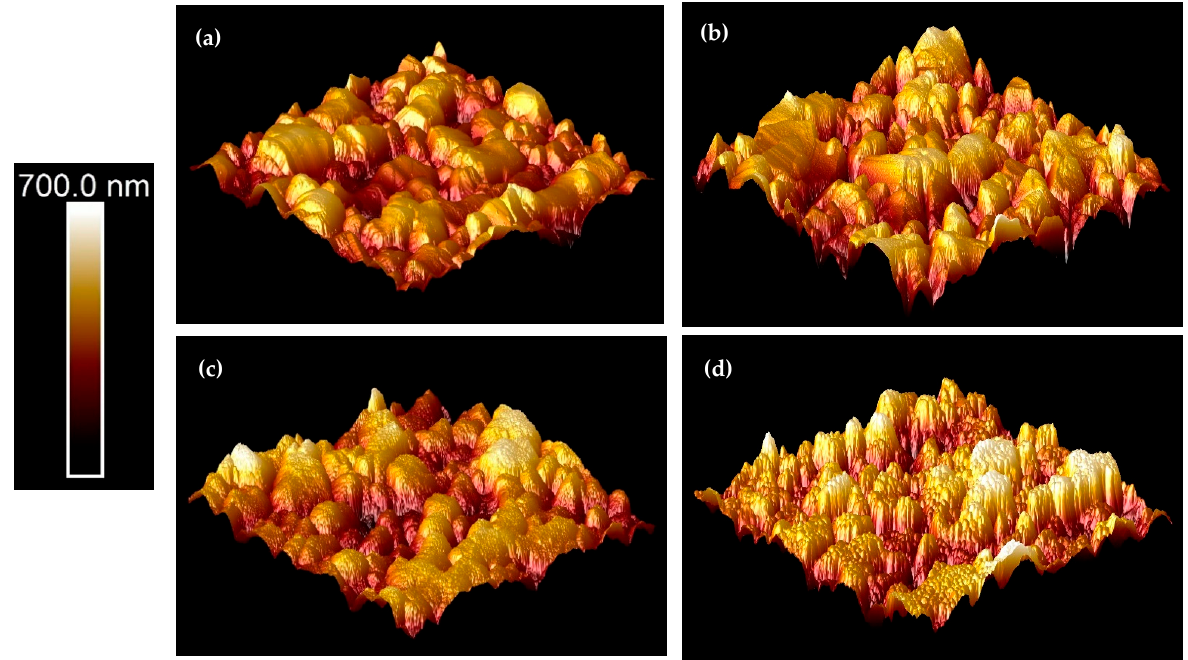
Figure 5. Surface roughness evolution measured by AFM: of the ( a ) Al 2 O 3 substrate; ( b ) RF_800; ( c ) RF_1000; and ( d ) RF_1200 samples. The color scale on the left side represents the surface height.